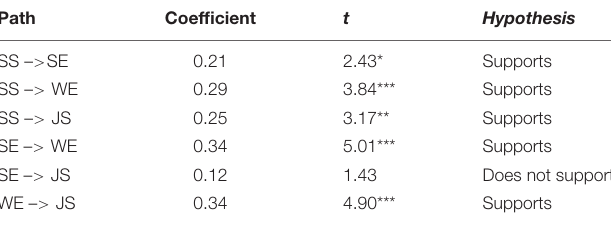
TABLE 7 | Result of the hypothesis